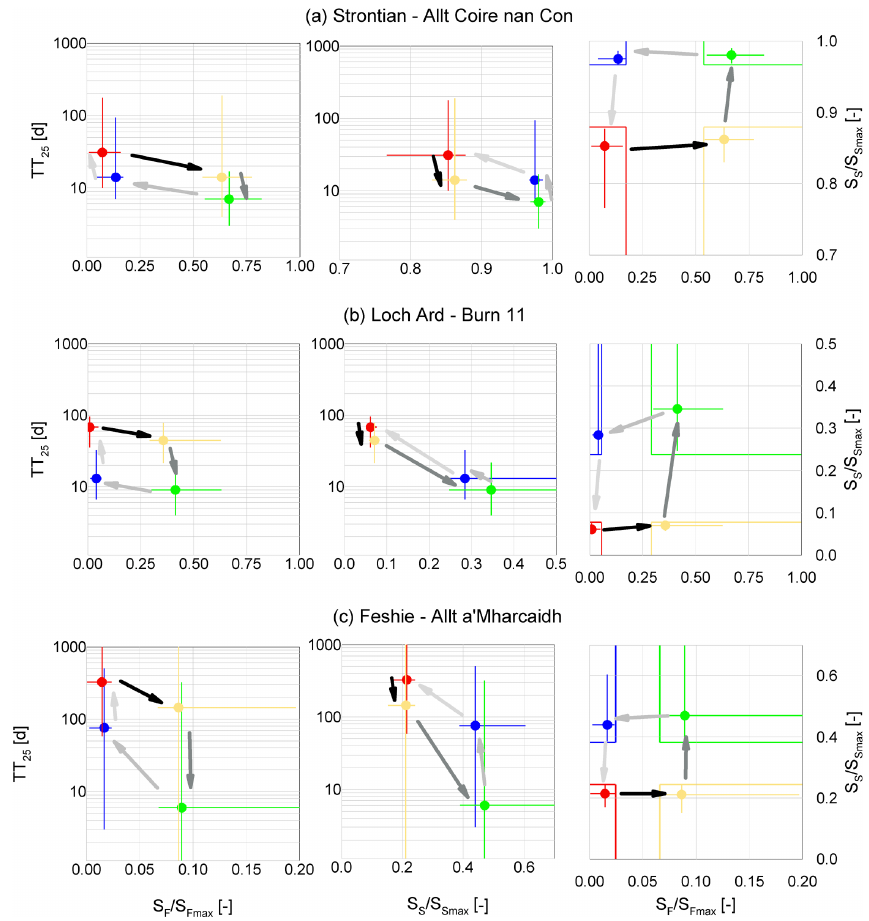
Fig. 12. Evolution of water age, here represented by the median of the 25th percentiles (TT 25 , colored dots) of all p F,Qtot during the four distinct hydrological regimes as represented by normalized S S and S F (see Fig. 5). The whiskers represent the 5th and 95th percentiles of all time steps within a given hydrologic regime. The arrows indicate the direction of the hysteresis. Note, that the rather noisy actual evolution paths between the median TT 25 were omitted for